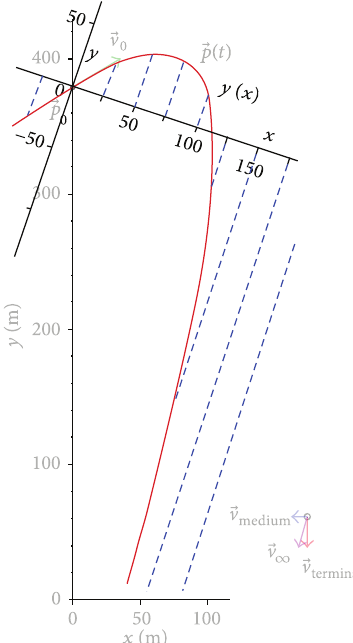
Figure 9: The same Empire State Building trajectory example as from Figure 1 but seen from the principal frame of